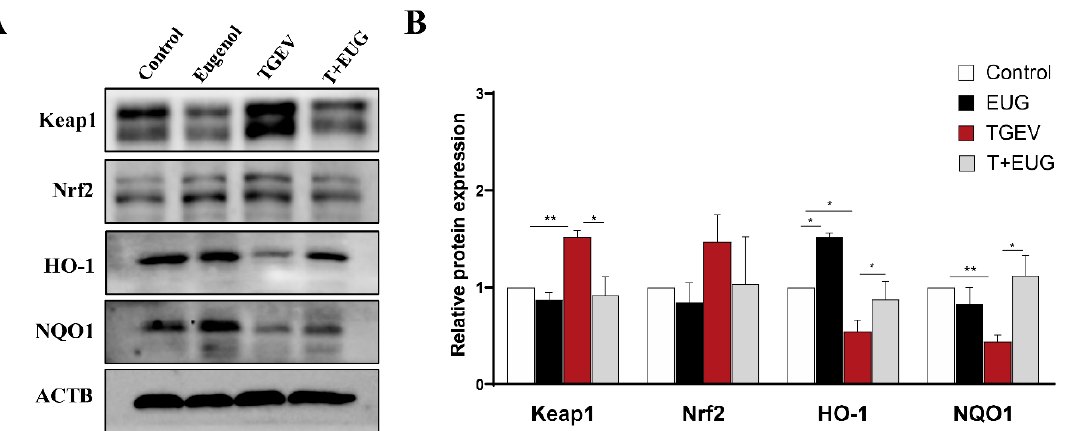
Figure 3. Effects of eugenol on jejunum antioxidation-related protein in TGEV-infected weaned piglets. ( A , B ) Protein abundance of Keap1, Nrf2, HO-1 and NQO1 in jejunum mucosa ( n = 3). Data are expressed as the mean ± SEM. * p < 0.05, ** p < 0.01.